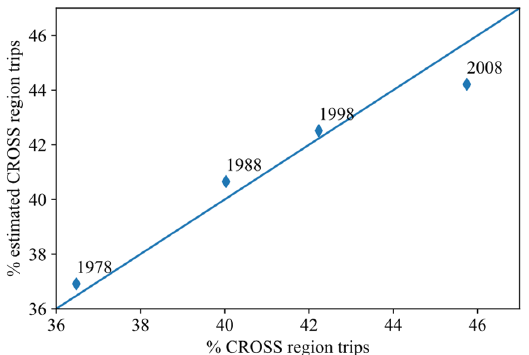
Figure 19. The predicted and the real proportion of cross ‐ region trips.